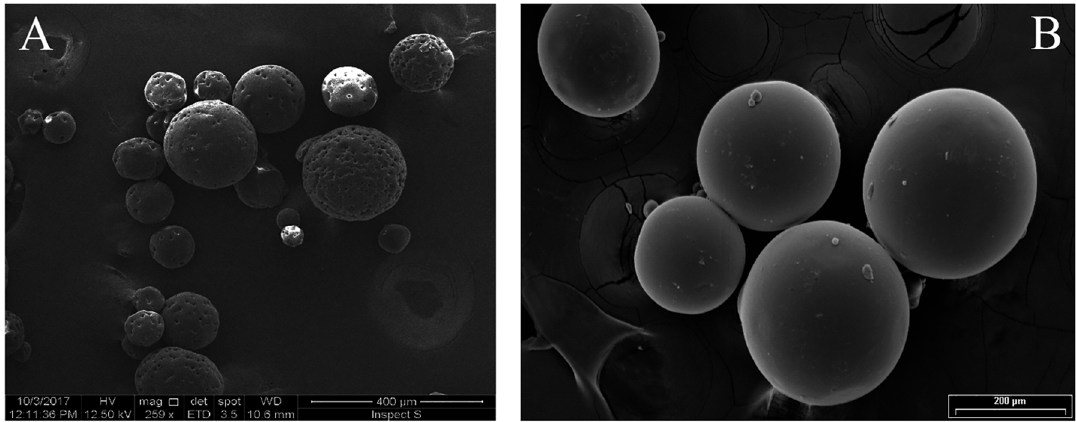
The PVA/PVAc-Rhodamine microspheres presented a diffractogram similar to that of the PVA/PVAc microspheres, with a high Bragg diffraction intensity in the region between 2ϴ= 10-30°, which can be related to their amorphous structure.